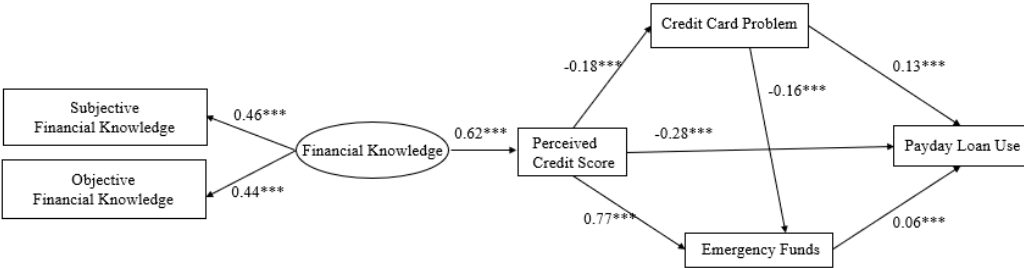
Figure 1. Structural equation model of relationship between financial knowledge, perceived credit score, credit-card problems, emergency funds, and payday loan use, with observed coefficients. * p < 0.05; ** p < 0.01; *** p < 0.001.